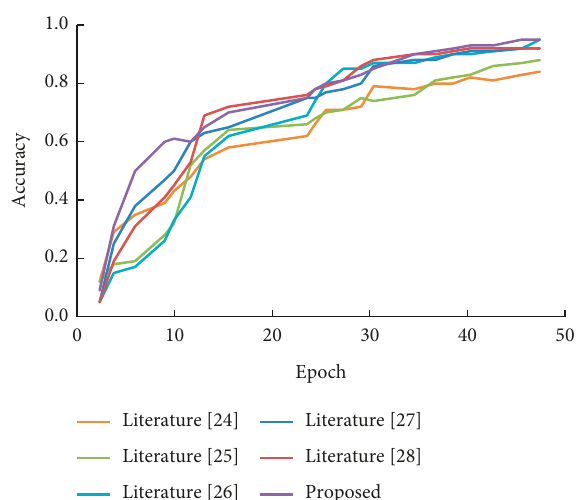
Figure 5: NTU-RGB+ D data set training result graph: accuracy.